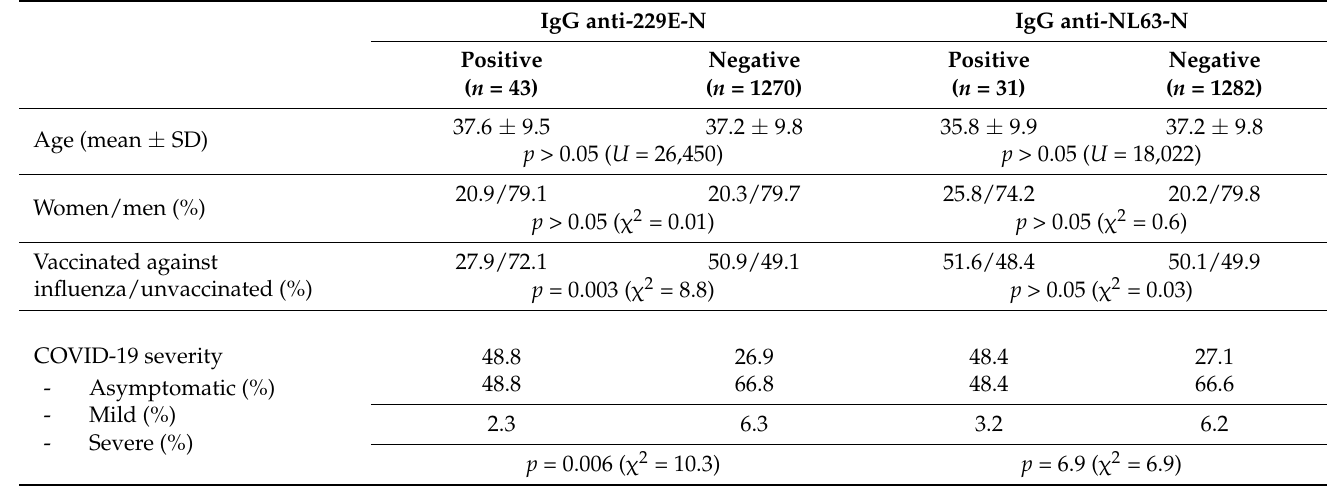
Table 3. Main characteristics of patients with IgG antibodies against 229E and NL63 nucleocapsid